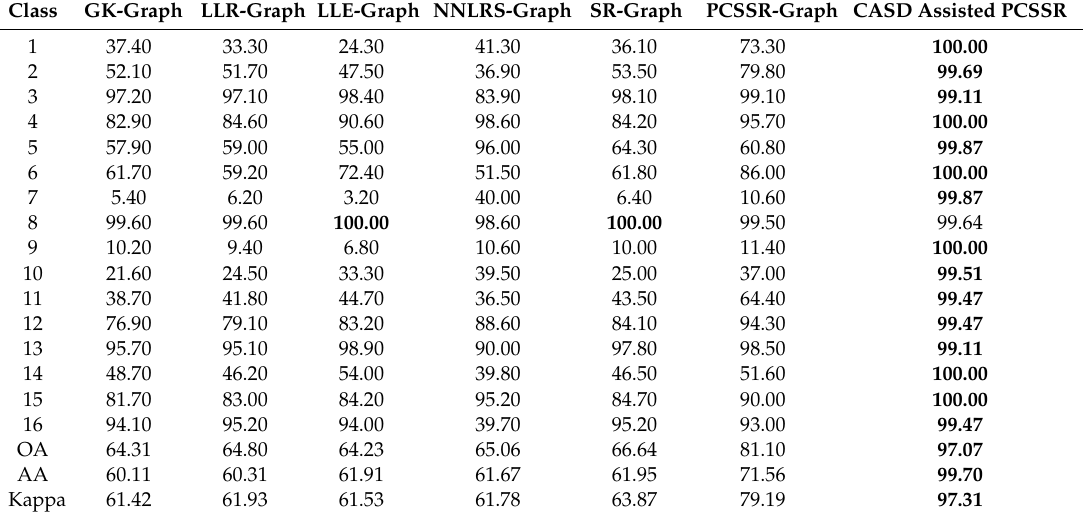
Table 5. Classification accuracy of each class, OA, AA and Kappa coe ffi cients for truncated IND PINE data with 16 classes (15 training samples for each class). The highest value of each row is shown in